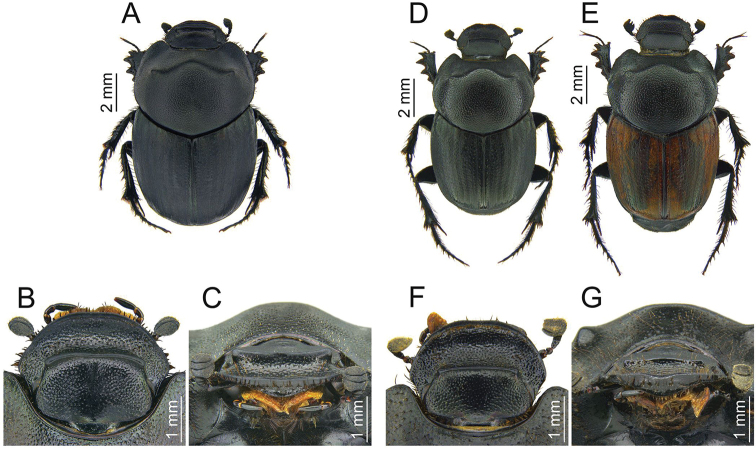
Key characters in two sibling species A–CEuonthophagus
gibbosus: A habitus B head, dorsal view C head, frontal view D–GEuonthophagus
koshantschikoffi: D, E habitus F head, dorsal view G head, frontal view.